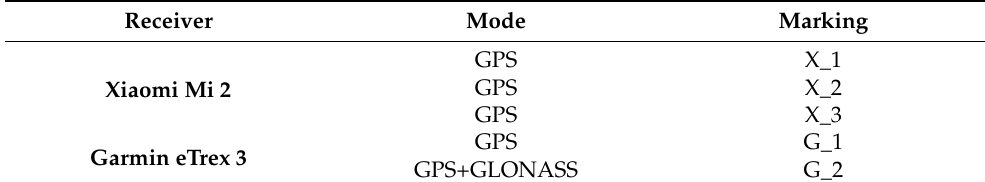
Table 1. Summary of receivers used for measurement.